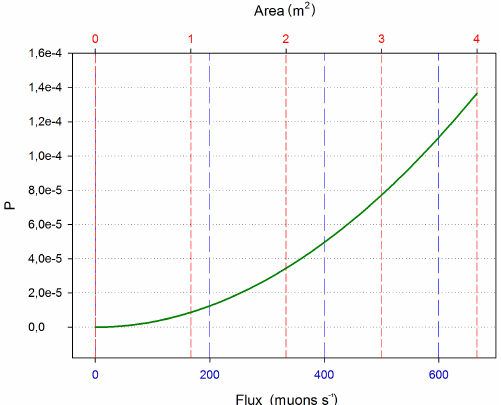
Figure 10. Poisson distribution. Probability of detecting as coinci- dent two different muons in a period of δt = 25µs as a function of muon flux (lower axis) or scintillator area (upper axis) at sea